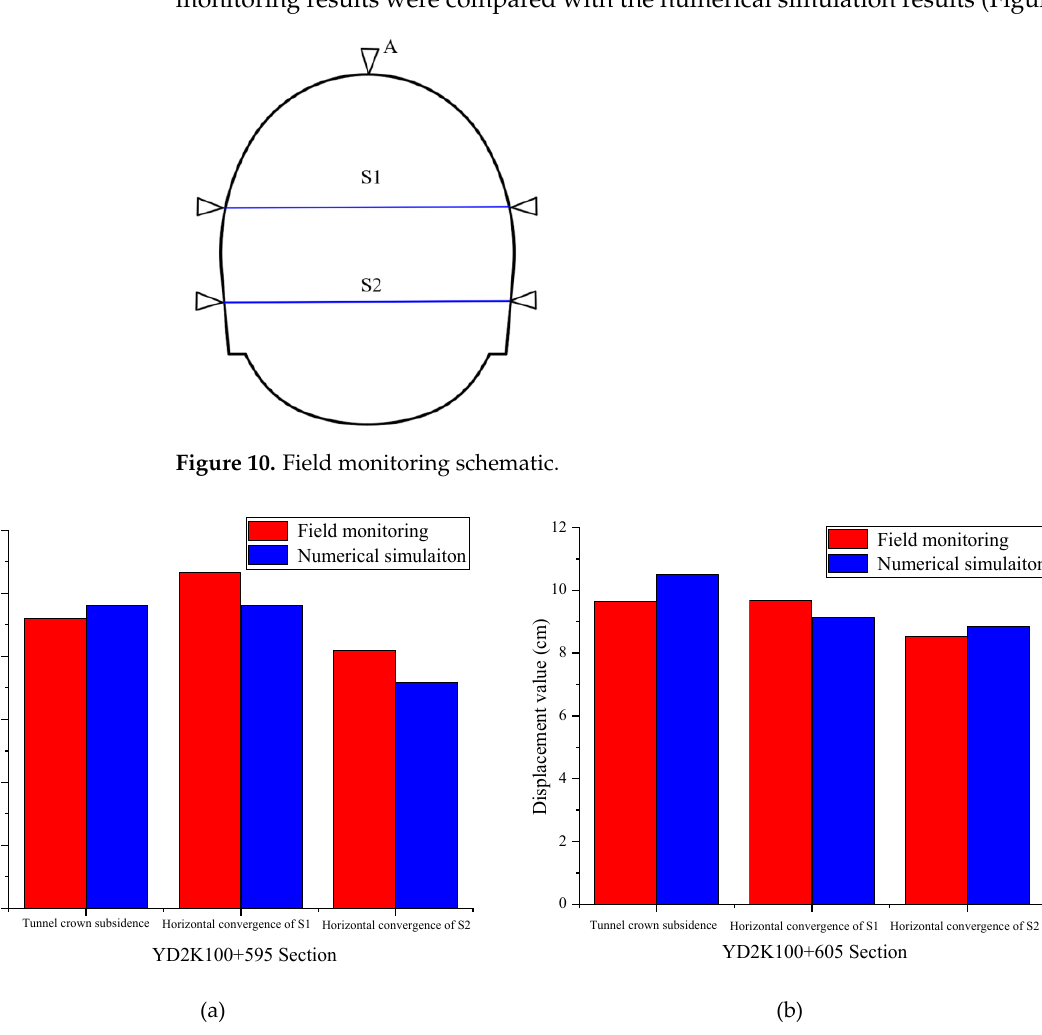
Figure 11. Comparison of the field monitoring results and the numerical simulation results: ( a ) tunnel cross-section YD2K100+595; ( b ) tunnel cross-section YD2K100+605. As shown in Figure 11, the difference between the measured value and the simulated value of the vault settlement of the right tunnel at YD2K100+595 was 5.5%. The difference between the measured value and the simulated value of the accumulated deformation in the horizontal direction of measurement line S1 was 10.8%. The difference between the measured value and the simulated value of the accumulated deformation in the horizontal direction of measurement line S2 was 14%. The difference between the measured value and the simulated value of the vault settlement of the right tunnel at YD2K100+605 was 8.2%. The difference between the measured value and the simulated value of the accumu- lated deformation in the horizontal direction of measurement line S1 was 6%. The differ- ence between the measured value and the simulated value of the accumulated defor- mation in the horizontal direction of measurement line S2 was 3.4%. By comparing the numerical simulation results with the field monitoring data, the model fitting error of the horizontal convergence between the vault settlement and the construction entrance side of the tunnel was mainly negative, with a maximum error of − 1.03 cm; the model fitting error of the horizontal convergence between the construction exit side was positive, with